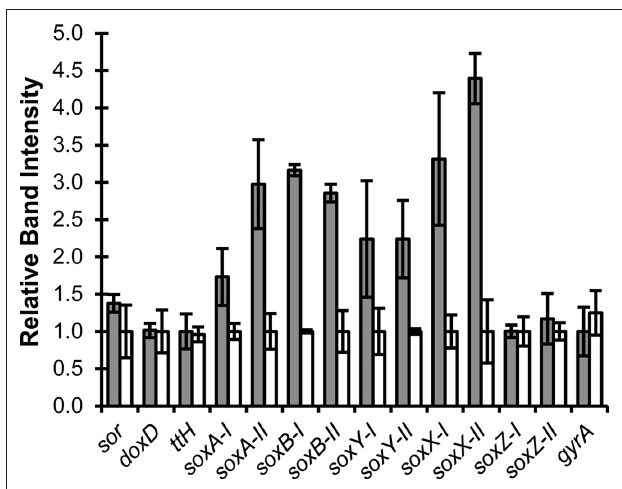
FiguRe 2 | RNA transcript profiles of selected genes predicted to be involved in A. caldus inorganic sulfur compound metabolism. Shown are the means of relative band intensities from semi quantitative RT-PCR products of three to four replicates with standard deviations. RNA was extracted from cells grown on tetrathionate (gray columns) or S 0 (white